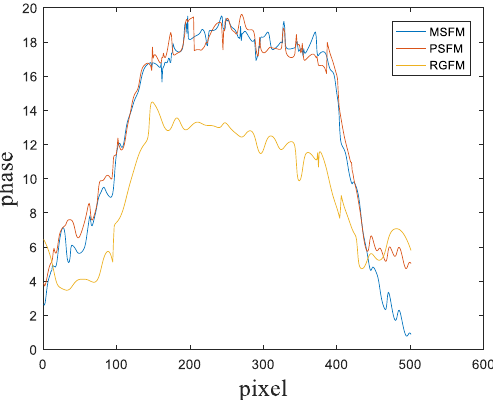
Figure 8. Profile with different spatial filtering methods. The blue, red, and yellow lines are the profiles of Figure 6a, Figure 6b, and Figure 6c,